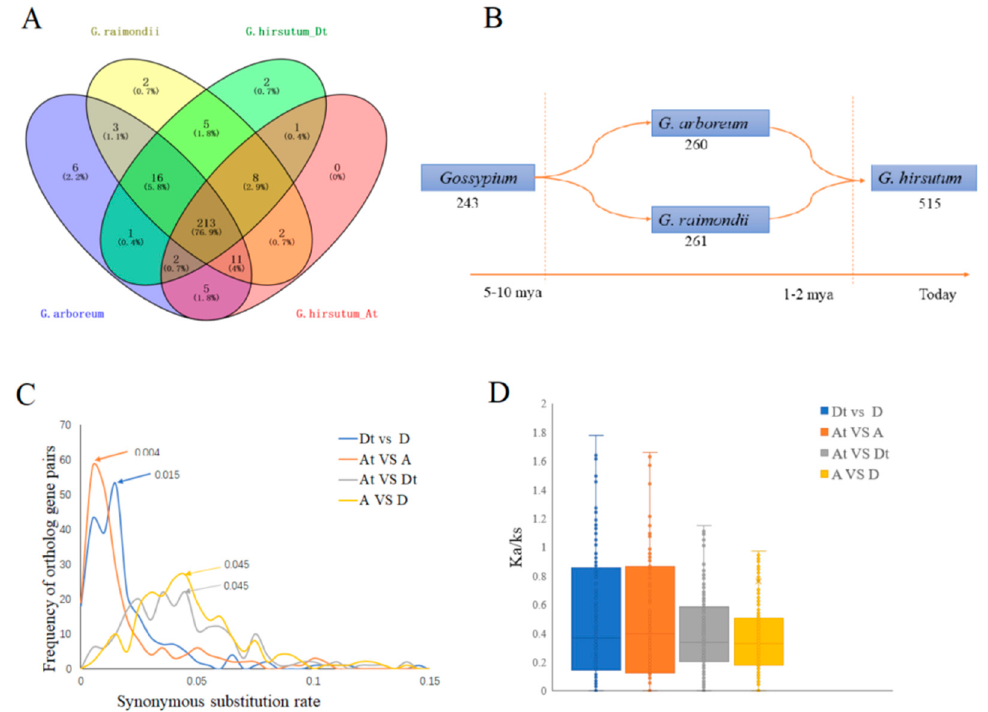
Figure 3. Orthologous gene pairs and evolution analysis of the ROS genes network in G. arboreum , G. raimondii , and G. hirsutum . ( A ) Orthologous gene pairs of the ROS genes network. ( B ) The orthologous genes pairs changes with a temporal depiction of phenomena that characterize polyploid evolution in Gossypium. ( C ) Distribution of K s values for orthologous genes pairs between the A genome ( G. arboreum ), D genome ( G. raimondii ), and two subgenomes of TM-1( G. hirsutum At subgenome and Dt subgenome). At Dt;‘ t’ indicates tetraploid. Peak values for each comparison are indicated with arrows. ( D ) Distribution of K a / K s value between the A genome, D genome and two subgenomes of TM-1.